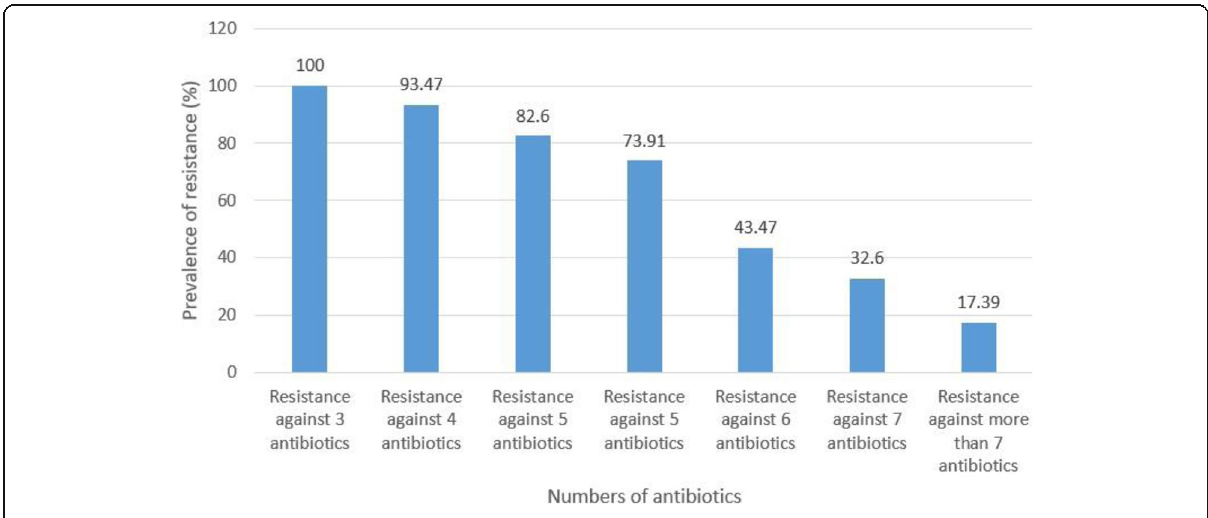
Fig. 1 Prevalence of multidrug-resistant S. epidermidis strains in hospital infectious